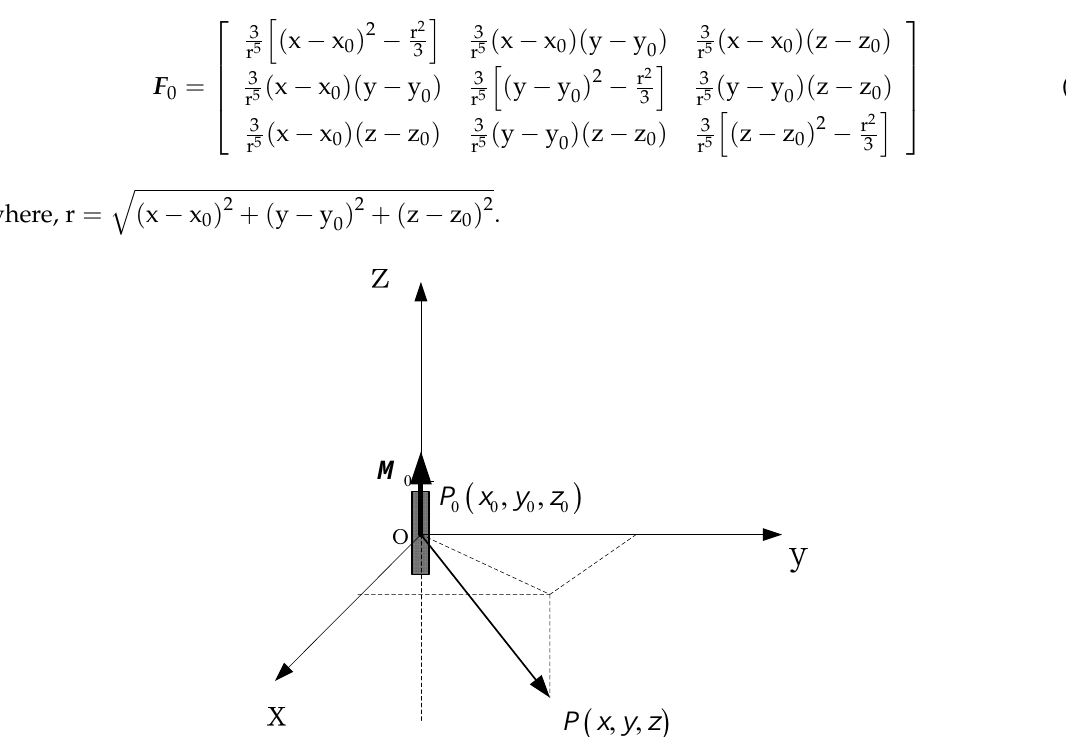
Figure 2. Coordinate of relative position between target and